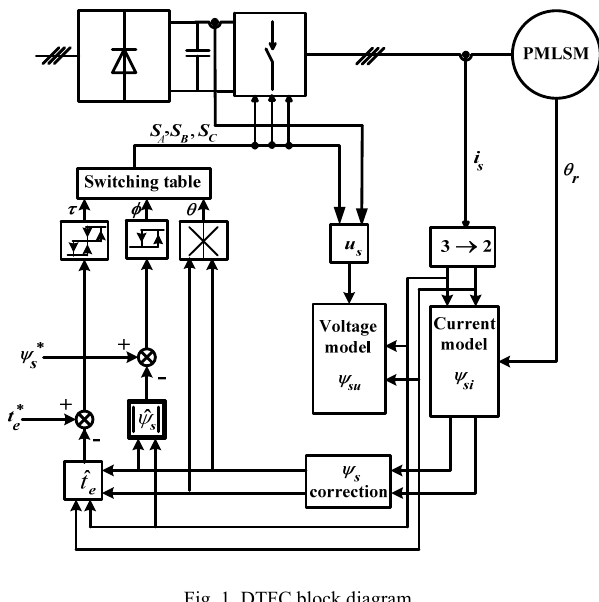
Fig. 1. DTFC block